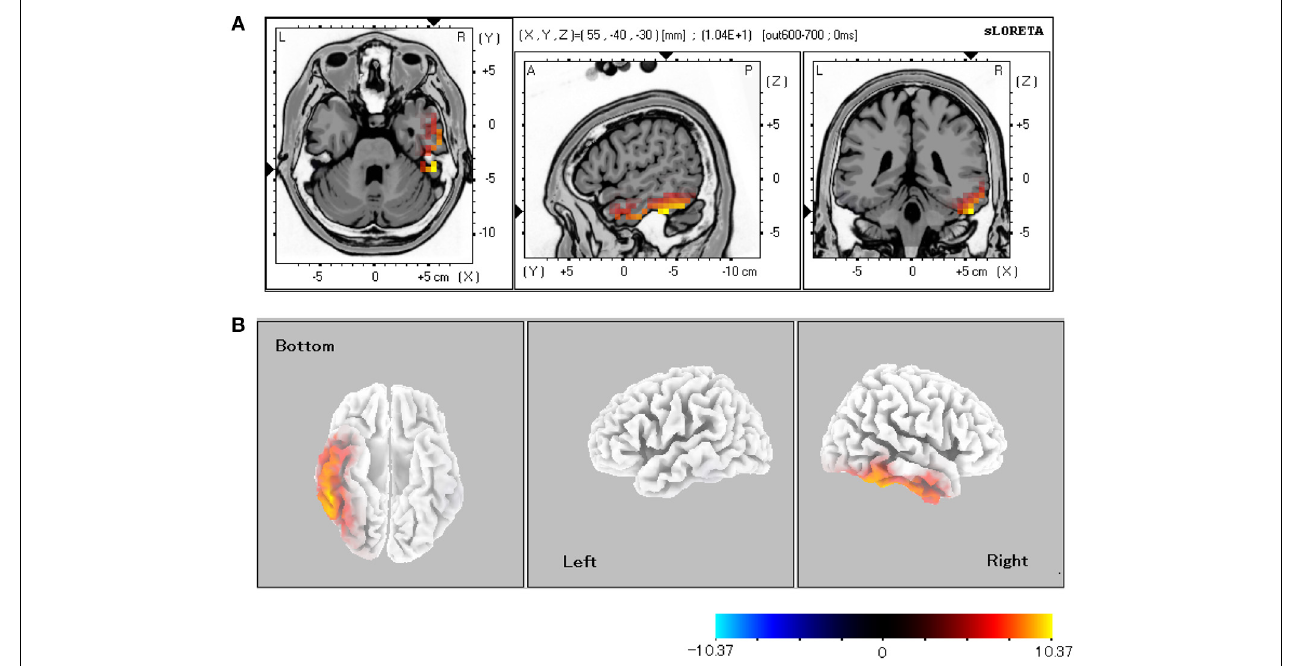
FIGURE 3 | sLORETA comparison of source localizations between the CS + and CS − conditions. (A) MRI planes (Colin27 brain) in the axial, sagittal, and coronal views and (B) cortical maps from the bottom, left, and right sides of the average among the 600–700-ms latencies (CS + vs. CS − ).